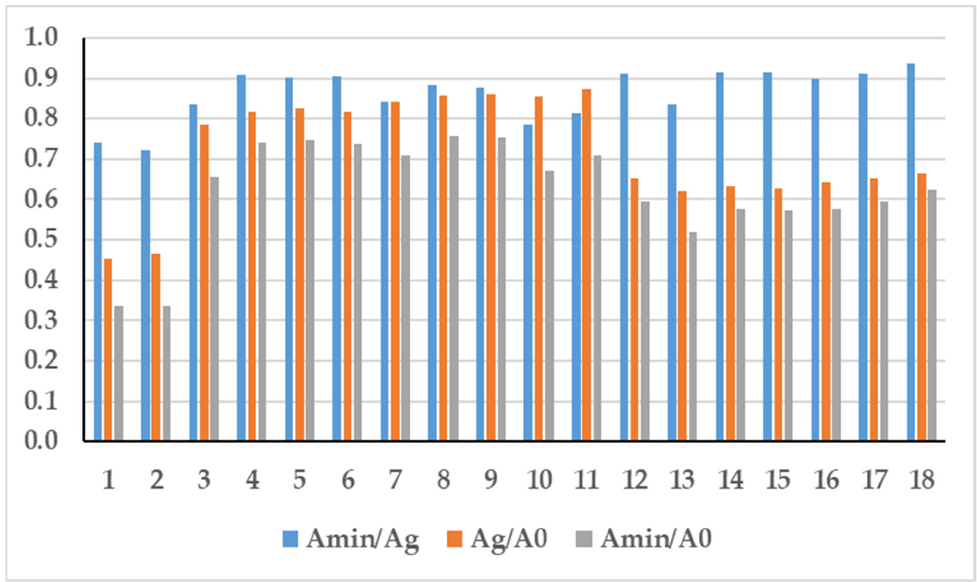
Figure 14. Ratios of the minimum A min , nominal cross-sectional area A 0 and the “average” area determined based on the weight loss A g — φ 10.